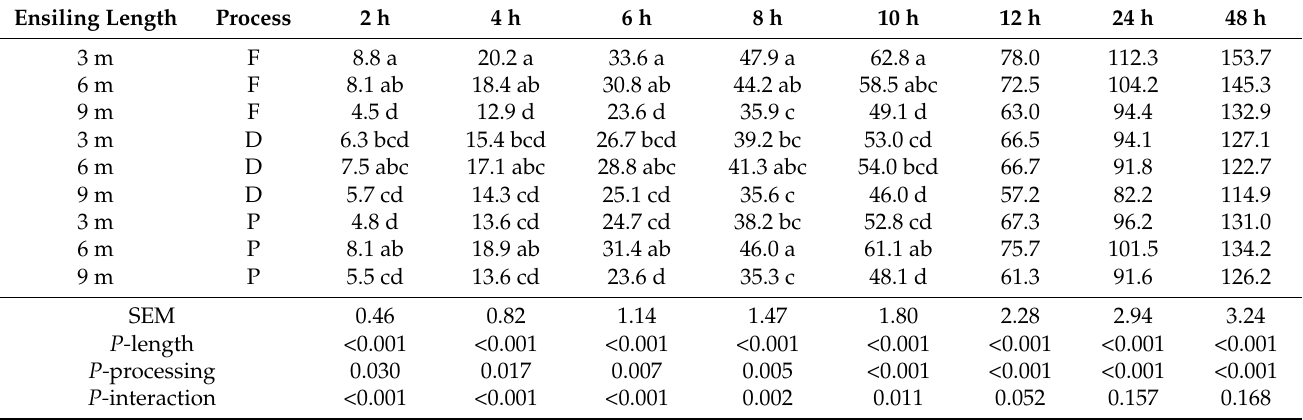
Table 3. In vitro gas production (mL/g OM) as an index of the fermentation pattern of silages opened after 3, 6, and 9 months, before (F) and after heat processing (dehydrated, D, or dehydrated and pelleted,